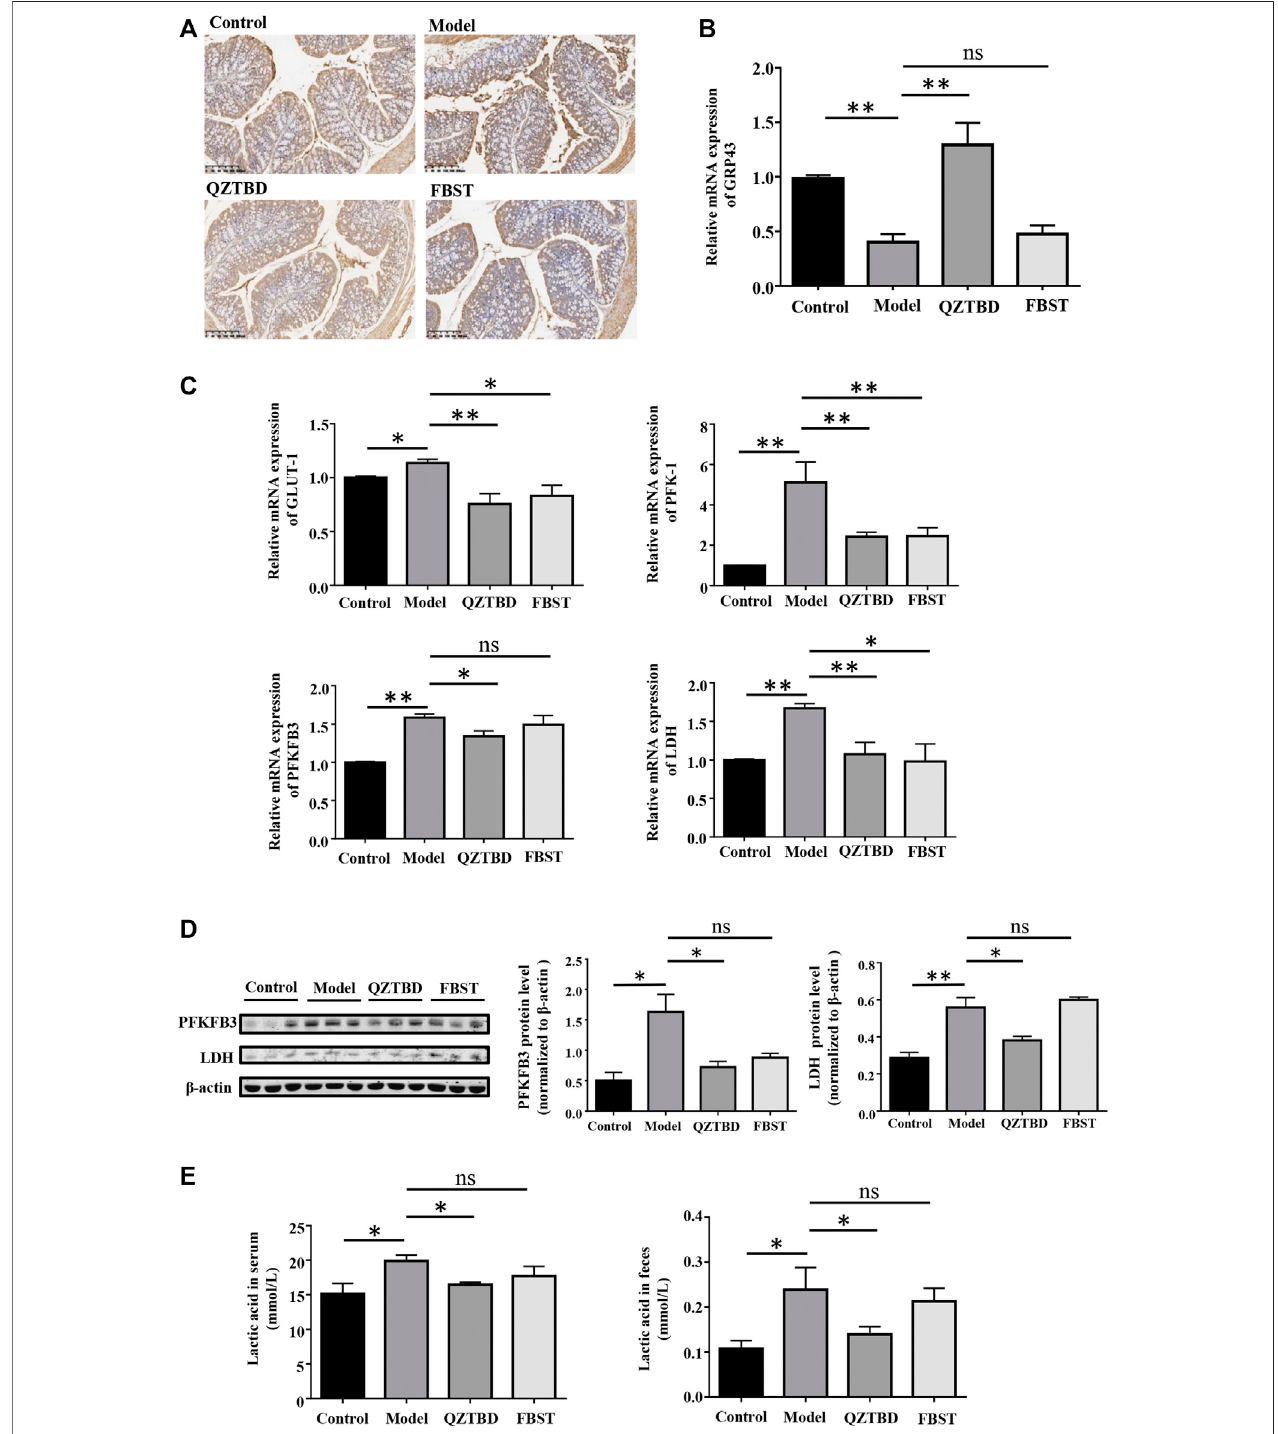
FIGURE 7 | QZTBD modulated the expression of GPR43 and metabolic phenotype. Expression of GPR43 in the colon were measured by immunohistochemistry (A) and q RT-PCR (B) ;ThemRNAexpressionofkeyglycolyticenzymes(GLUT1,PFK1,PFKFB3,andLDH)intheintestinaltissues (C) ;TheproteinexpressionofPFKFB3 and LDH in the colon were measured by Western blotting (D) . The concentration of lactic acid in serum and feces (E) . “ ns ” represents not signi fi cant; “ * ” represents p < 0.05, “ ** ” represents p < 0.01 and “ *** ” represents p < 0.001. N (cid:2) 7/group.